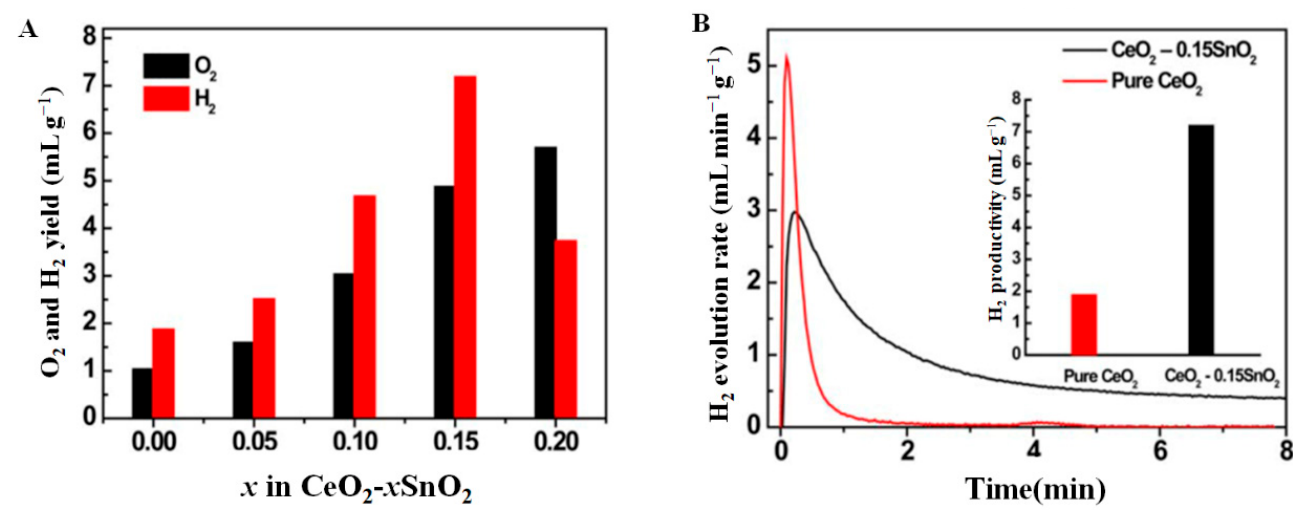
Figure 5. ( A ) Evolution of O 2 and H 2 for CeO 2 − x SnO 2 (x = 0.05–0.20) during redox reactions. ( B ) H 2 evolution rate during water-splitting reaction at 800 ◦ C for CeO 2 –0.15SnO 2 and pure CeO 2 . Adapted with permission from Ref. [72] , Copyright 2017, Wiley.